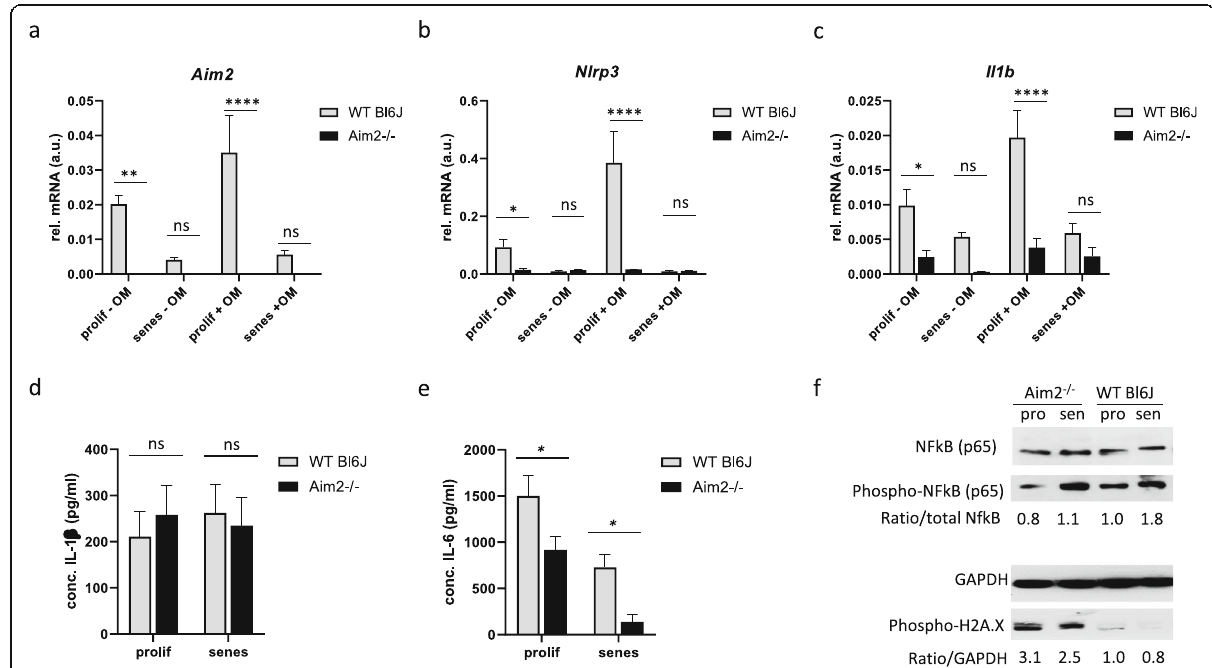
Fig. 3 Deletion of Aim2 gene attenuates the inflammatory response in aortic VSMC of mice. a - c Analysis of mRNA expression of Aim2 ( a ), Nlrp3 ( b ), Il1b ( c ), by real-time RT-PCR ( n = 3 measurements of 3 experiments for each). Total RNA was extracted from VSMC grown in vitro with normal growth medium ( − OM) or osteoblast mineralization medium (+ OM) at day 14. A.u. arbitrary unit; relative expression of target gene was normalized against expression of housekeeping genes ( Actb, Gapdh and B2m ). d , e Concentrations of secreted IL-1 β ( d ) and IL-6 ( e ) in the supernatant of WT and Aim2 − / − VSMC was determined by ELISA. Data show the mean and SEM of n = 3 independent VSMC pools analyzed in duplicate. a - e Data were tested by one-way ANOVA. ns: not significant, *: P < 0.05, **: P < 0.01, ****: P < 0.0001 f Protein expression of